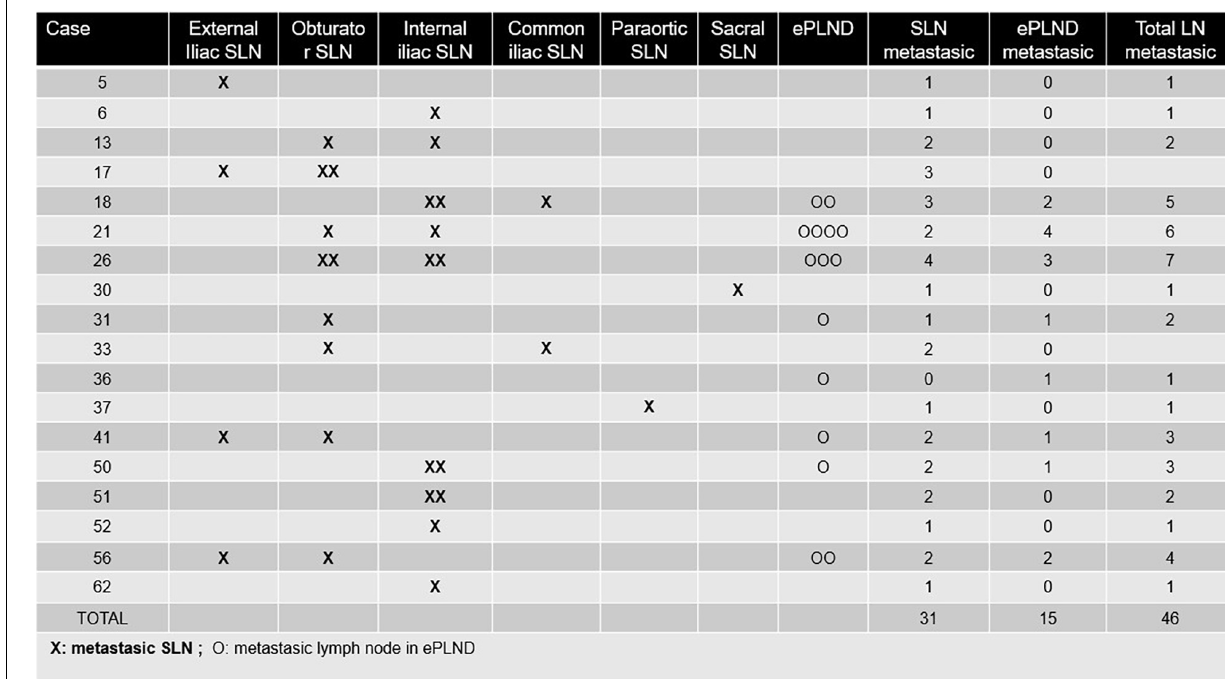
FIGURE 3 | Regional distribution of LN metastasis. X, metatstasic SLN; O, metastasic lymph node in